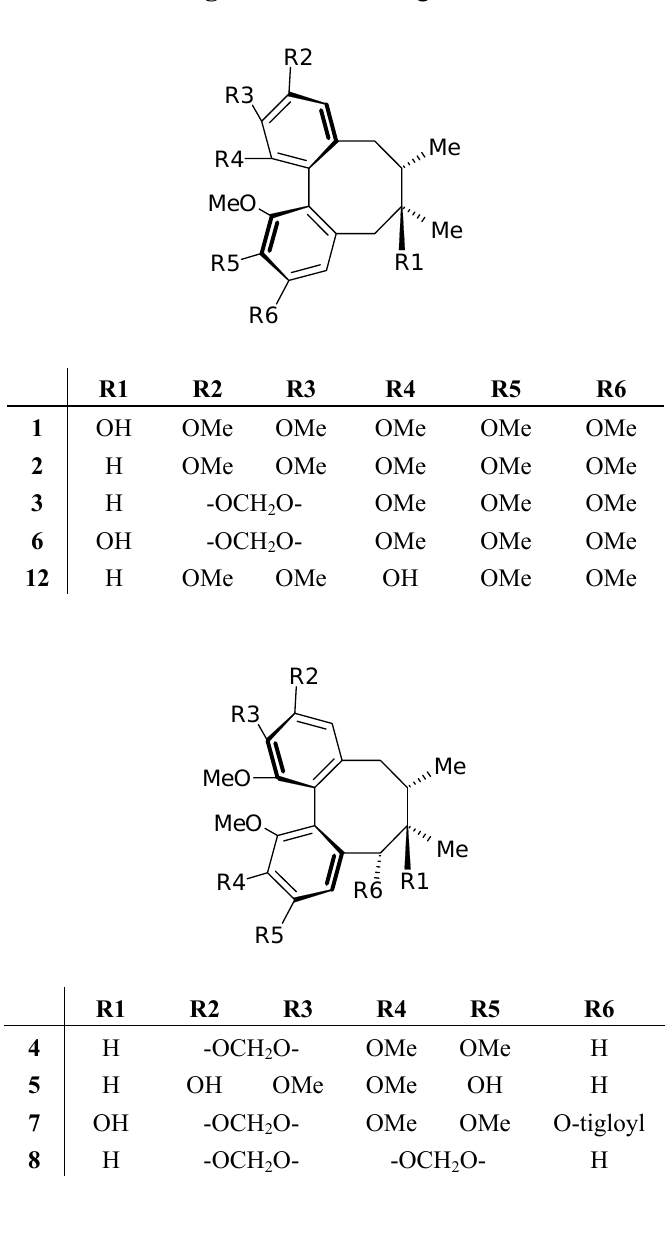
Figure 1. Studied